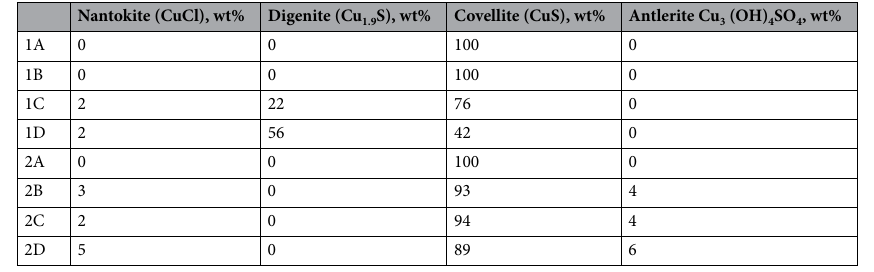
Table 1. Copper phases composition (wt.%) of depth profile samples of the two